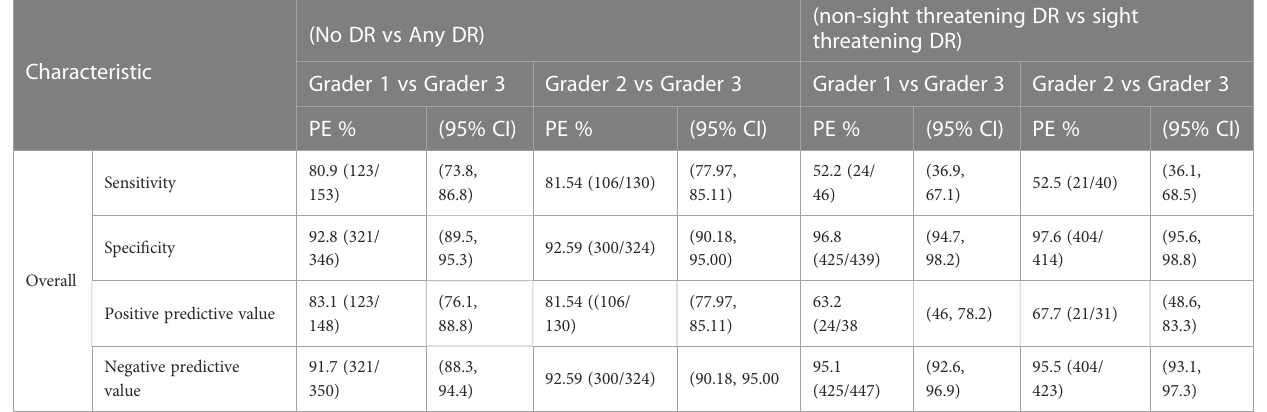
TABLE 3 Overall Sensitivity, Speci fi city, Positive predictive value and Negative predictive value.